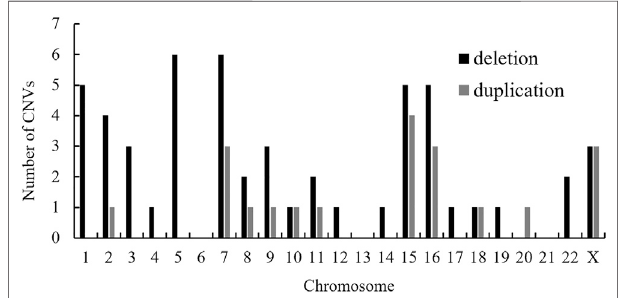
FIGURE 2 | Chromosomal distribution of CNVs identi fi ed in the present study. Abbreviation: CNV, copy number